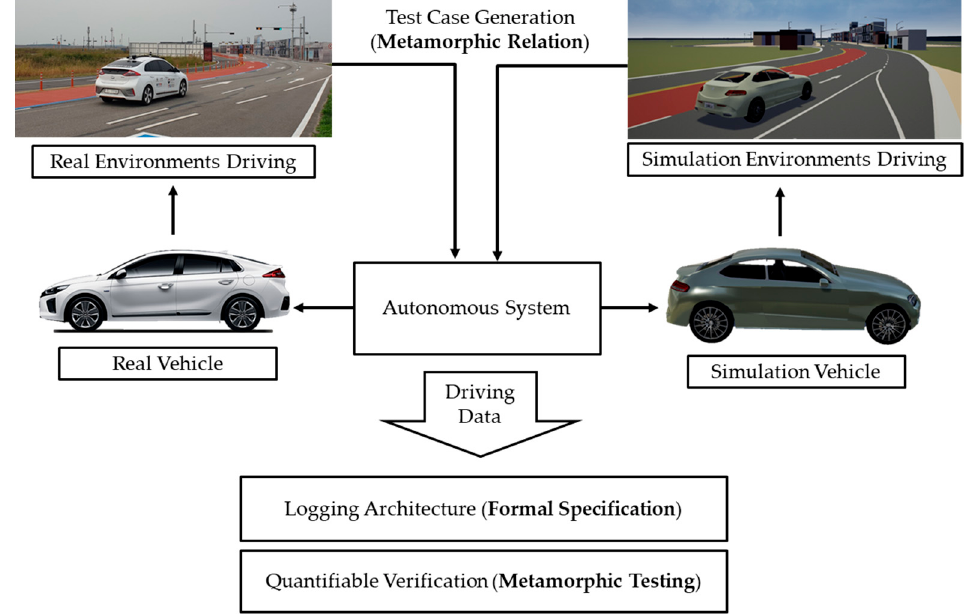
Figure 1. Overview of a formal and quantifiable log analysis framework.